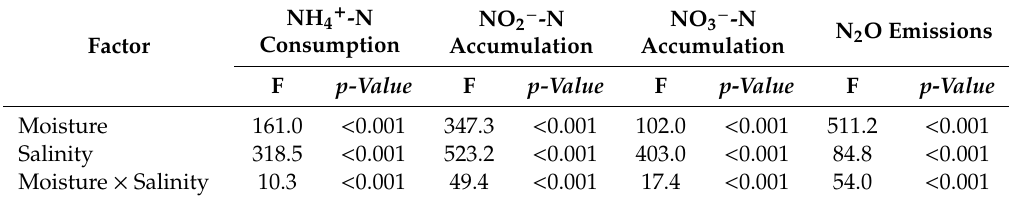
Table 2. Two-way ANOVAs for NH 4 + -N consumption, NO 2 − -N accumulation, NO 3 − -N accumulation and N 2 O emissions. Di ff erent lowercase letters indicate significance levels of p < 0.05 among salinity treatments, respectively.